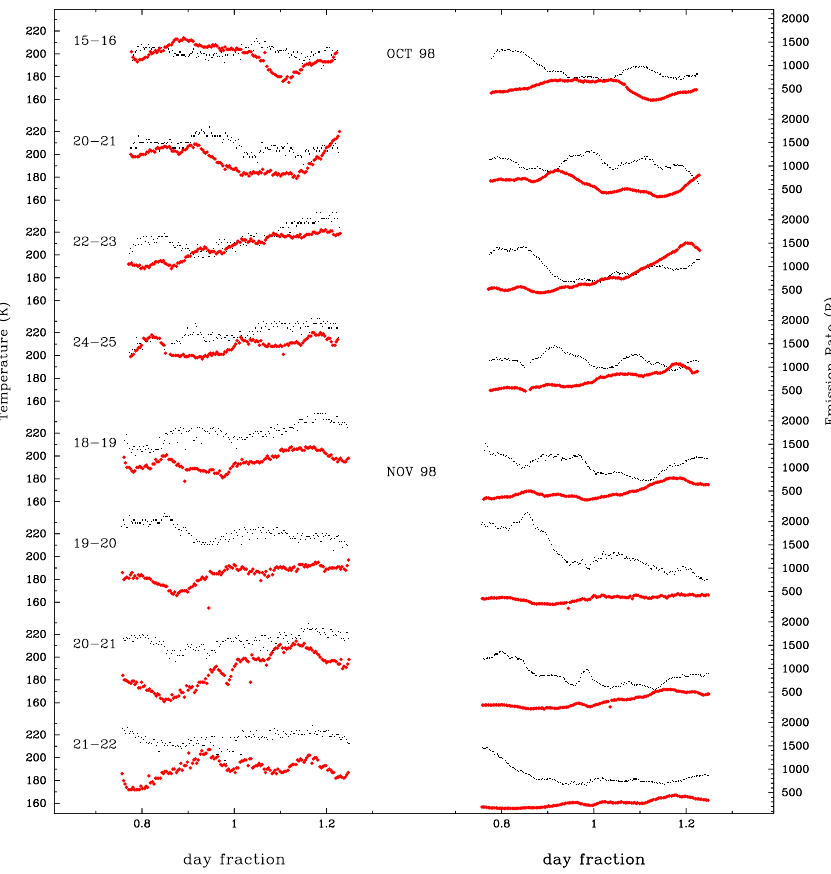
Fig. 3. Rotational temperatures and emission. Dark circles: from the O 2 (0–1) atmospheric band. Points: from the OH(6–2) Meinel